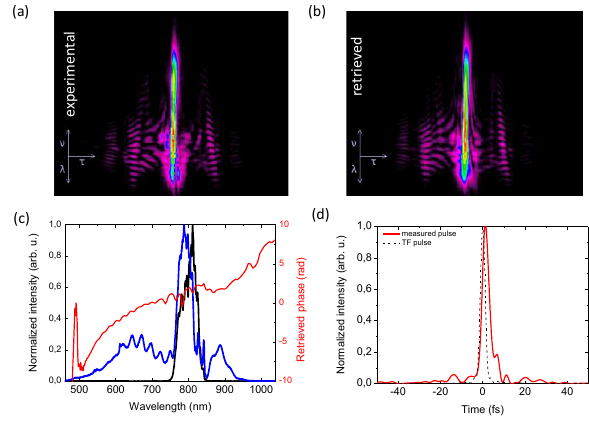
Fig 2. FROG measurement of the 2.5 mJ 1.5-cycle pulse. Panels (a) and (b) display respectively measured and retrieved FROG traces. Panel (c) displays initial (black line) and broadened (blue line) spectra with the retrieved spectral phase (red line). Panel (d) shows the retrieved temporal pulse shape (red line) and the calculated Fourier transform pulse (black dashed